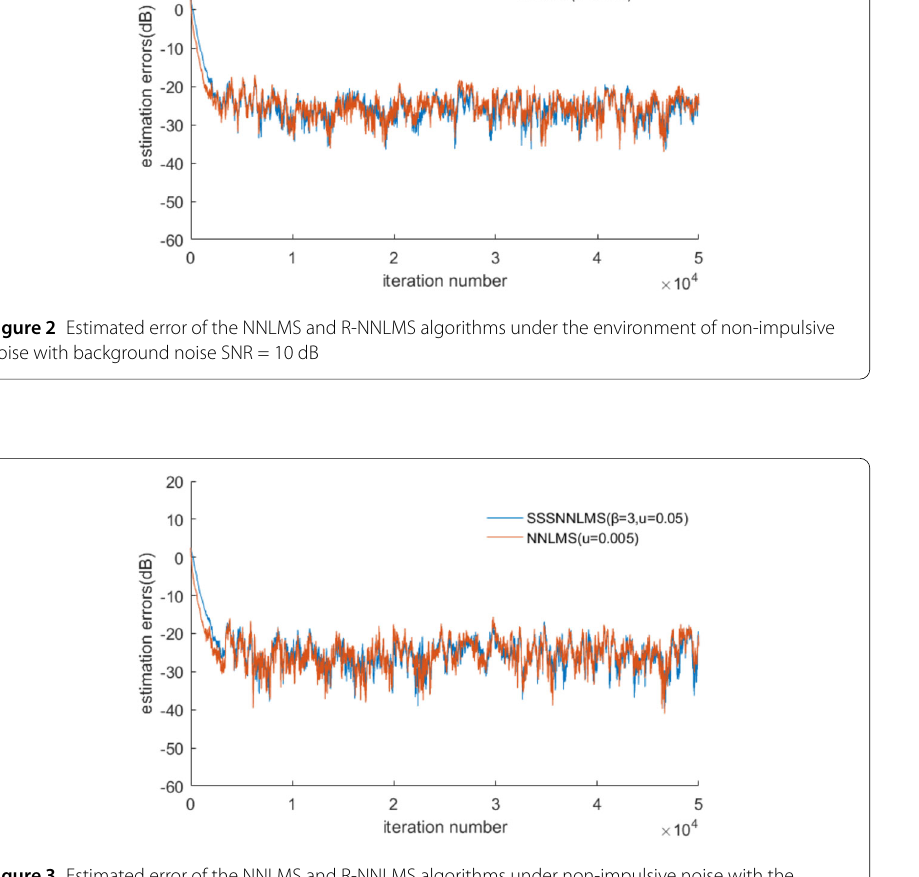
Figure 3 Estimated error of the NNLMS and R-NNLMS algorithms under non-impulsive noise with the uniformly distributed background noise in between ±